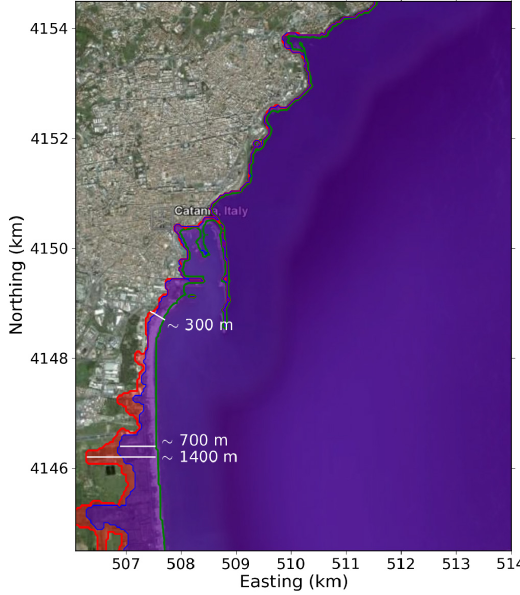
Fig. 14. Maximum inundation lines obtained for the aggregate stan- dard scenario (blue line) and for the aggregate augmented scenario (red